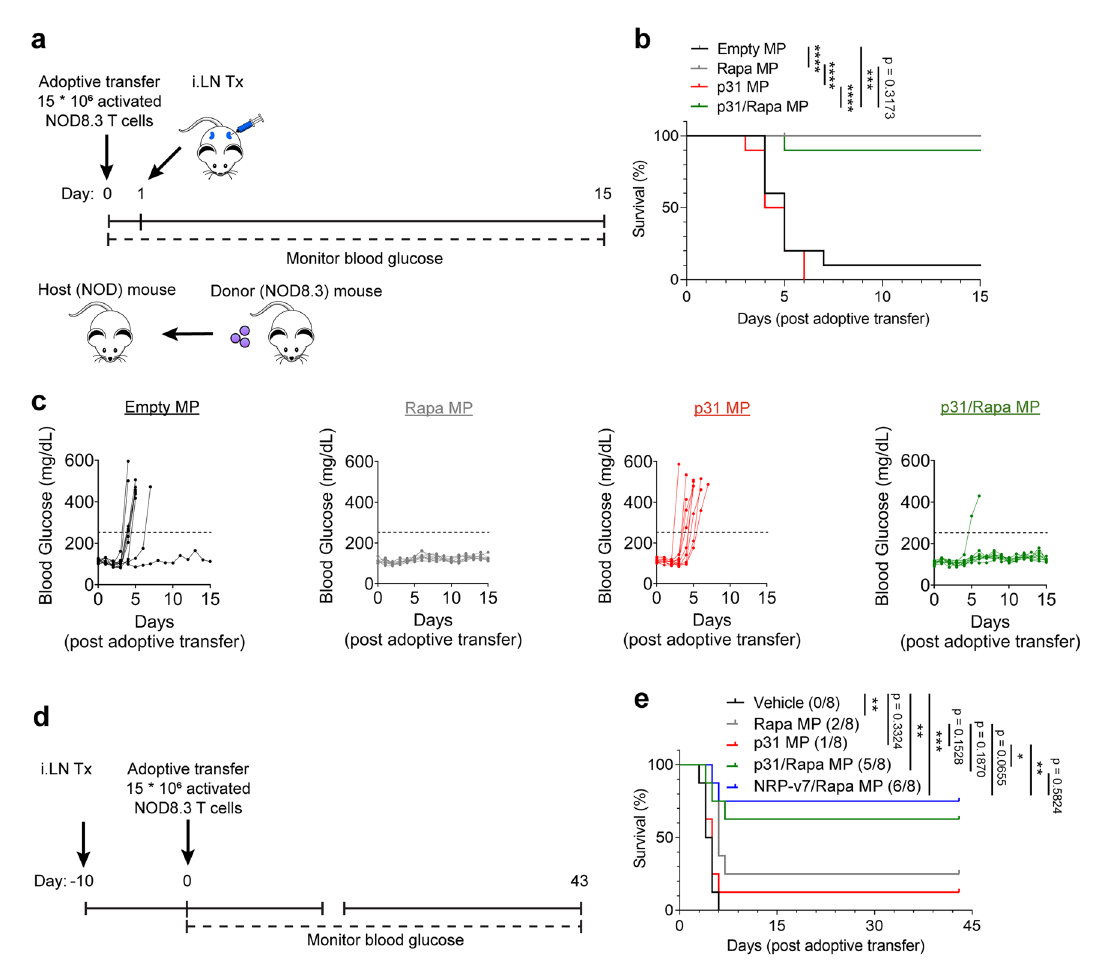
Fig. 8 | Both Rapa MP and antigen/Rapa MPs inhibit T1D induction in ther- apeutic regimens, while co-encapsulation of antigen with Rapa is required for durabletolerance.a Schematicrepresentationoftherapeutic iLN treatmentinthe NOD8.3 model of T1D. e Survival curve for experiment detailed in a . c Individual blood glucose traces for mice in each group. d Schematic representation of iLN treatment with delayed disease induction in the NOD8.3 model of T1D. e Survival curveforexperimentdetailedin d .Thenumberofsurvivingmiceineachtreatment